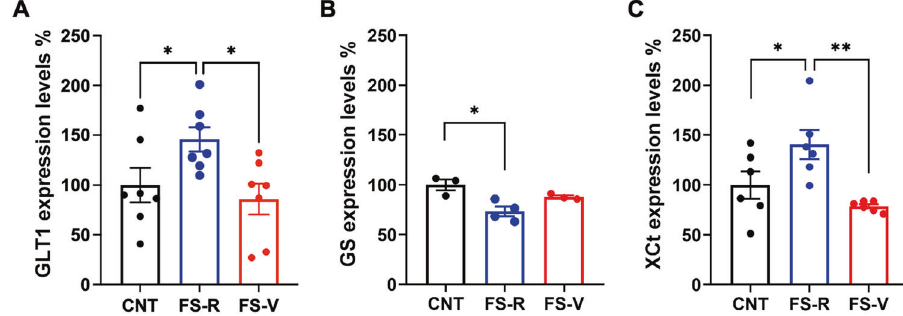
Table 4 summarizes the main functional and molecular differences highlighted between FS-R and FS-V animals. Sucrose intake test allows deeming rats resilient or vulnerable to acute footshock stress Anhedonia, the disruption of anticipation, motivation, and decision-making processes involved in obtaining a reward, is a core symptom of depression and other neuropsychiatric disorders [54, 55]. Typically, the sucrose intake test is used to assess the development of anhedonic phenotype induced by chronic stress [56, 57]. Here, we set up a novel paradigm based on differences in sucrose intake in acutely stressed rats, revealing the development of an anhedonic phenotype in about half of the stressed rats. We found no signi fi cant changes at the level of HPA axis activation 24 h after stress exposure, in line with previous evidence [1]. We demonstrated that FS-V animals remained anhedonic for 72 h after stress while, interestingly, FS-R and FS-V animals showed different behavioral phenotypes at least up to 2 weeks after acute FS exposure. These duration differences suggest that this paradigm generates different trajectories of resilient versus vulnerable stress response, thus allowing the dissection of the response and its readouts [2, 20]. Future studies are needed to draw a comprehensive time-dependent behavioral characteriza- tion of FS-R and FS-V animals in the days and weeks following stress exposure, thus analyzing speci fi c behavioral phenotypes which could clarify the translational relevance of the model.